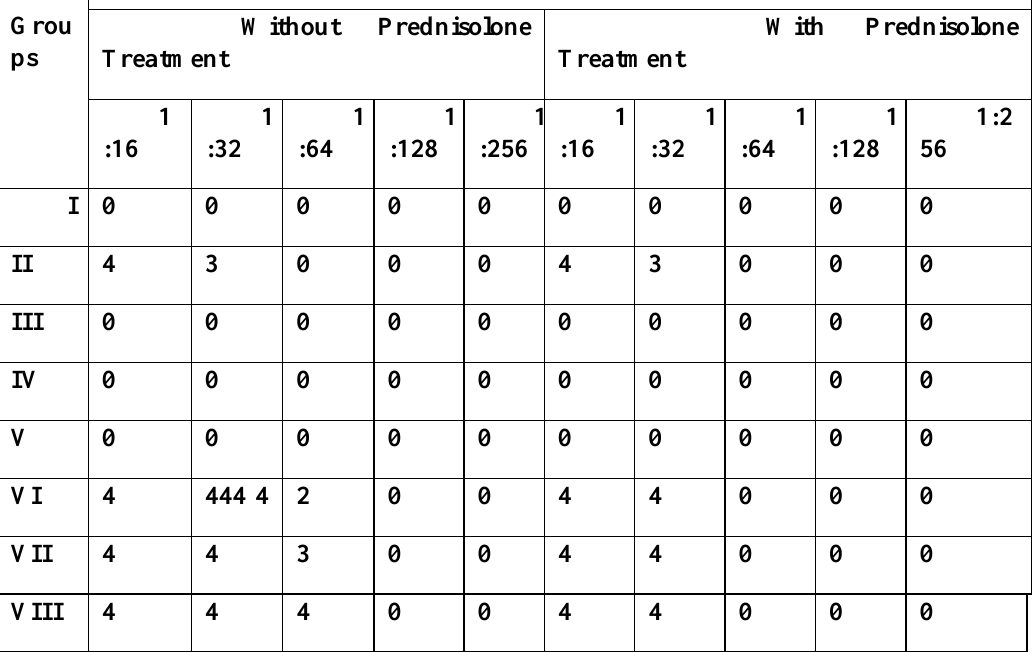
Anti- Brucella antibody titer by indirect Immunoflourescentin sera of treated mice. Number of Mice with a Positive Anti- Brucella Antibody Titer / 4 Animals Grou Without Prednisolone ps Treatment